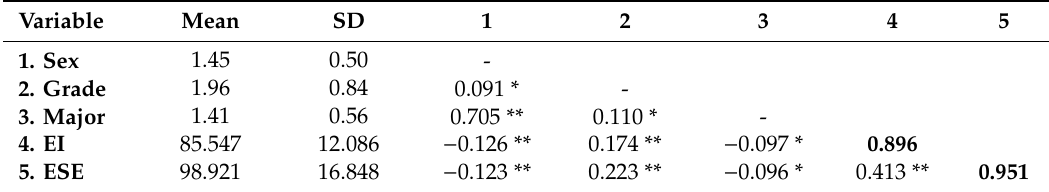
Table 5. Correlation description between entrepreneurial self-e ffi cacy scale and emotional intelligence scale.